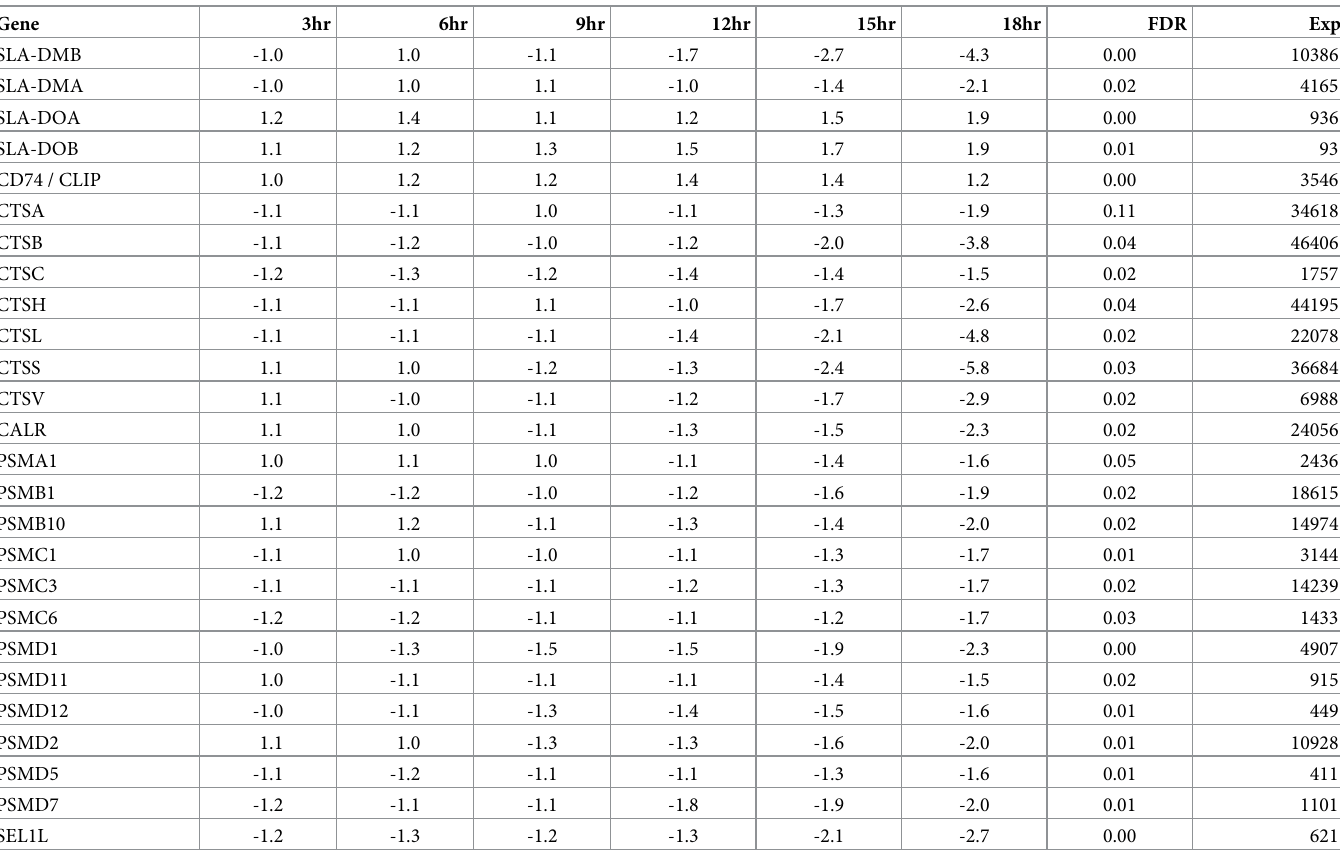
Table 7. Differential expression (fold = infected/non-infected) with a FDR less than 0.05 at one or more time points and the averaged expression level (Exp) of genes in MHC antigen processing and presentation between infected and non-infected macrophages at 3, 6, 9, 12, 15 and 18 hours post